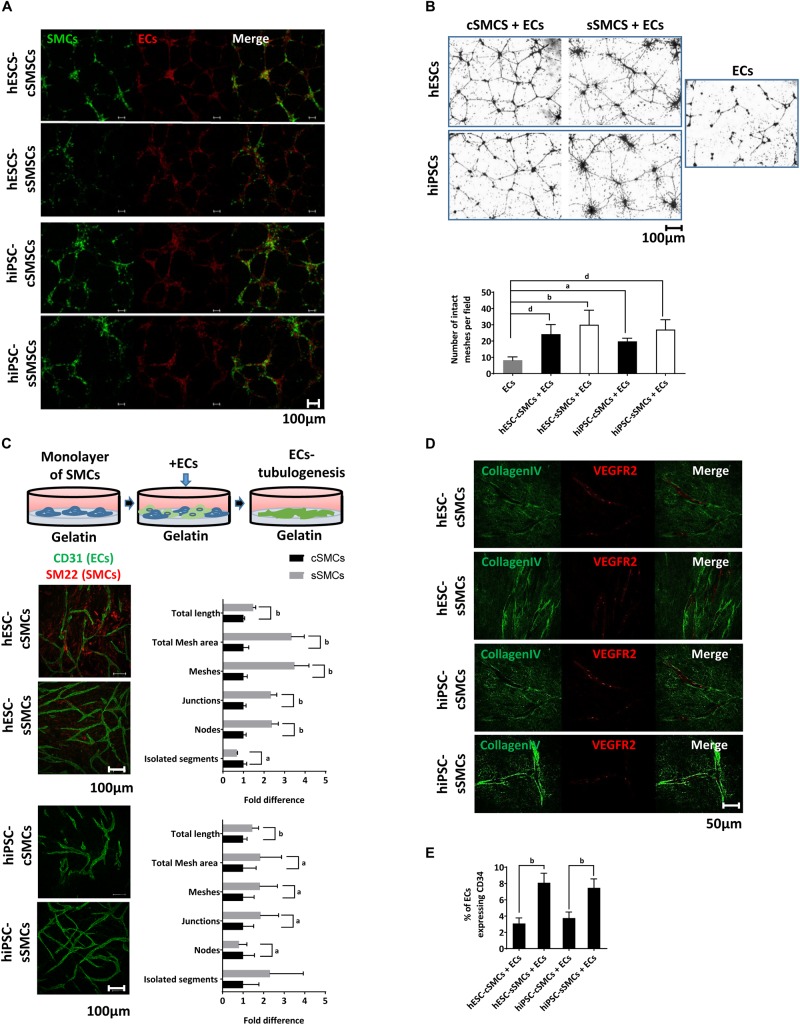
MC function of hPSC-cSMCs and hPSC-sSMCs. (A)
In vitro angiogenesis assay. hESC-cSMCs, hESC-sSMCs, hiPSC-cSMCs, and hiPSC-sSMCs labeled with PKH67, shown in green, were mixed in a ratio 1:9 with primary ECs labeled with PKH26, shown in red, and allowed to generate a vascular network on matrigel for 8 h. Merged fluorescence images are shown in right column of each panel. Images were taken on Leica TCS SP5 confocal microscope and are representative of three independent experiments. Scale bar, 100 μm. (B) Regression analysis. Phase-contrast images of hESC-cSMCs + ECs, hESC-sSMCs + ECs (upper left panel), hiPSC-cSMCs + ECs, hiPSC-sSMCs + ECs (lower left panel) and ECs (right panel) derived vascular networks on matrigel at 48 h are shown. (Images were taken on Zeiss axiovert 100, and are representative of three independent experiments. Number of intact meshes representing the vascular network integrity for each condition are shown in the chart. Graph data are expressed as means ± SD from three independent experiments. aP < 0.05, bP < 0.01, dP < 0.001. Scale bar, 100 μm. (C) Tubulogenesis assay. ECs were plated on a monolayer of hESC-cSMCs, hESC-sSMCs (upper images) or hiPSC-cSMCs, hiPSC-sSMCs (lower images) and allowed to generate tubule-like structures (illustration). Green fluorescence indicates ECs (CD31 staining). Images were taken on Leica TCS SP5 confocal microscope and are representative of three independent experiments. Morphometric analysis of the hESC-cSMCs + ECs, hESC-sSMCs + ECs and hiPSC-cSMCs + ECs, hiPSC-sSMCs + ECs tube-like structures is presented in the charts and expressed as fold change between the two conditions regarding various parameters. Analysis was performed with ImageJ software. Graph data are expressed as means ± SD from three independent experiments. aP < 0.05, bP < 0.01. Scale bar, 100 μm. (D) Immunofluoresence analysis of the hESC-cSMCs + ECs, hESC-sSMCs + ECs and hiPSC-cSMCs + ECs, hiPSC-sSMCs + ECs tube-like structures was performed. Green fluorescence indicates Collagen IV expression (left column) whereas red fluorescence indicates ECs (VEGFR2 staining) and the merge is shown in the right column. Images were taken on Leica TCS SP5 confocal microscope and are representative of three independent experiments. Scale bar, 100 μm. (E) The percentage of ECs expressing CD34 in hESC-cSMCs + ECs, hESC-sSMCs + ECs, hiPSC-cSMCs + ECs and hiPSC-sSMCs + ECs tube-like structures is presented in the chart. CD34 positive ECs were evaluated after cell detachment, double-staining with anti-CD31-FITC, anti-CD34-PE antibodies and flow cytometry analysis. The percentage of CD34 + /CD31 + cells ratio is expressed in the chart as means ± SD from three independent experiments. bP < 0.01.)